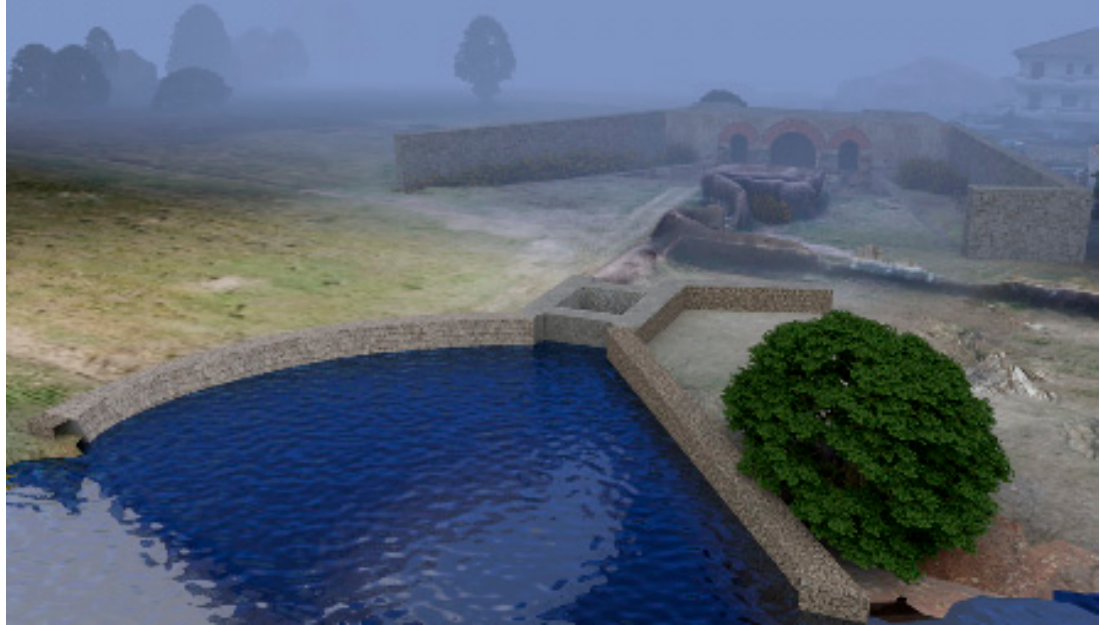
Figure 12. Rendering of incile as it would have appeared today if it would not have been